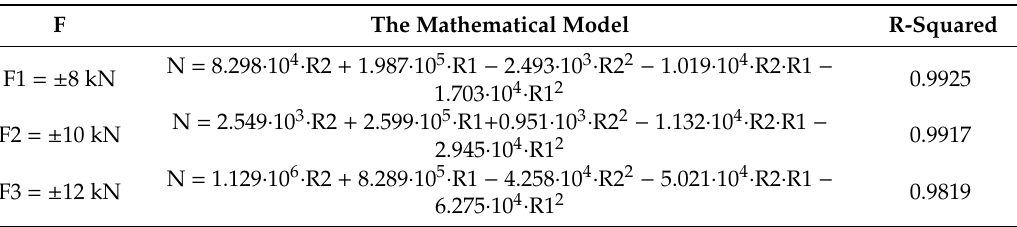
Table 8. Mathematical models of the dependence of the number of cycle n on the radii R1 and R2